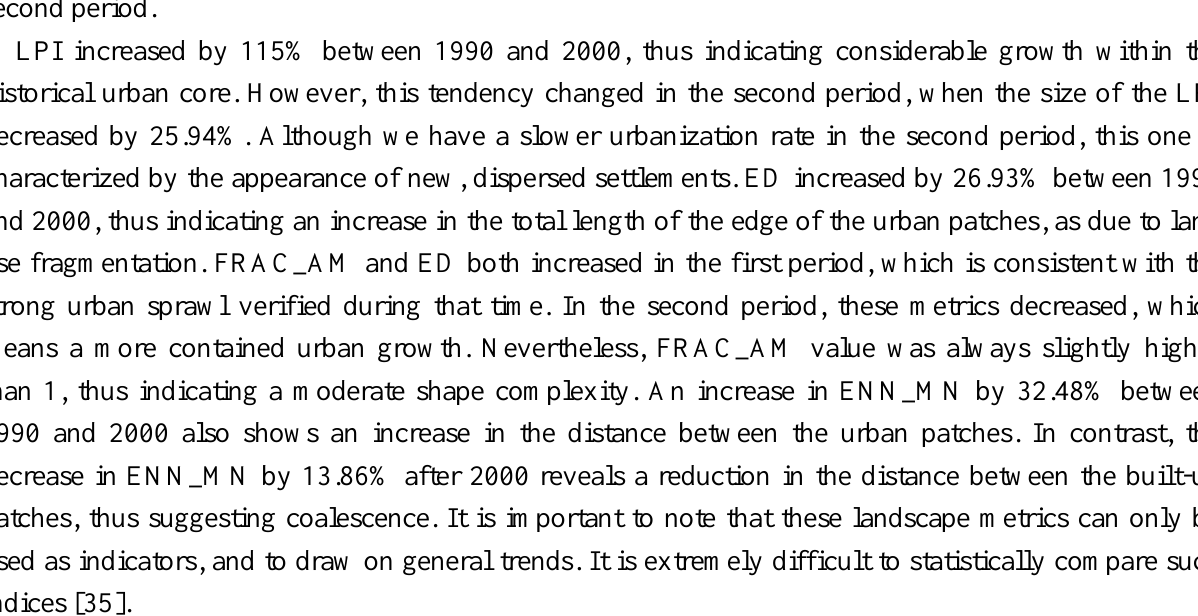
Table 6. Landscape indices and percentages of